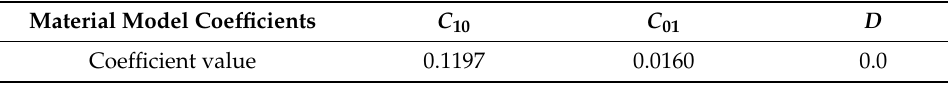
Table 1. Mooney-Rivilin model constitutive